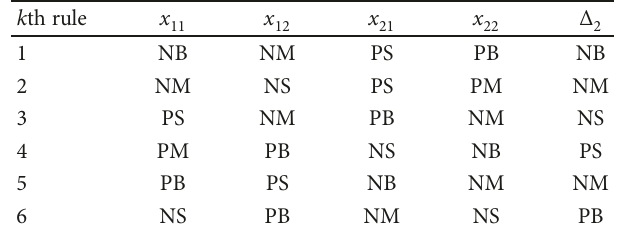
Table 1: Fuzzy rules of the FLS F